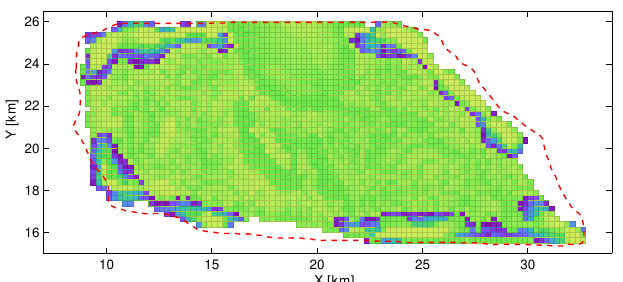
( b ) XY view. The red dotted line represents the limits of the real model (Figures 7 and 8).